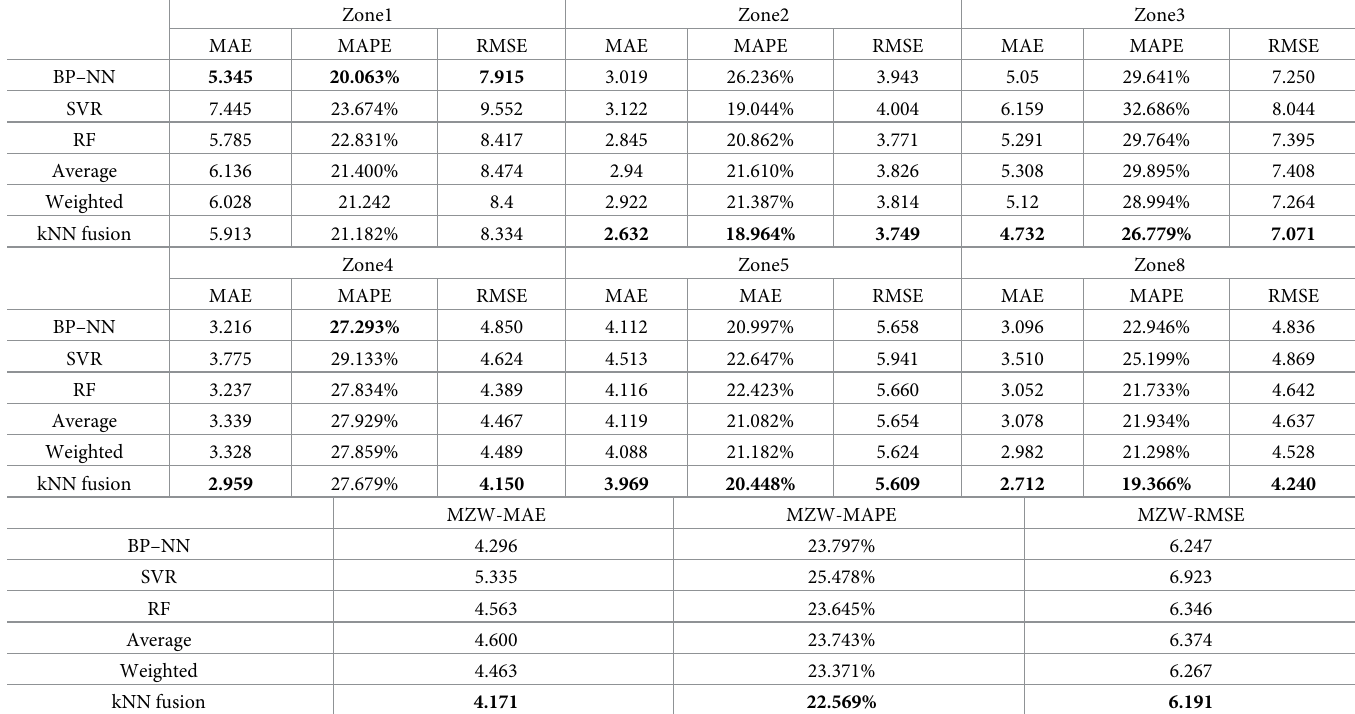
Table 1. Prediction accuracies of the different